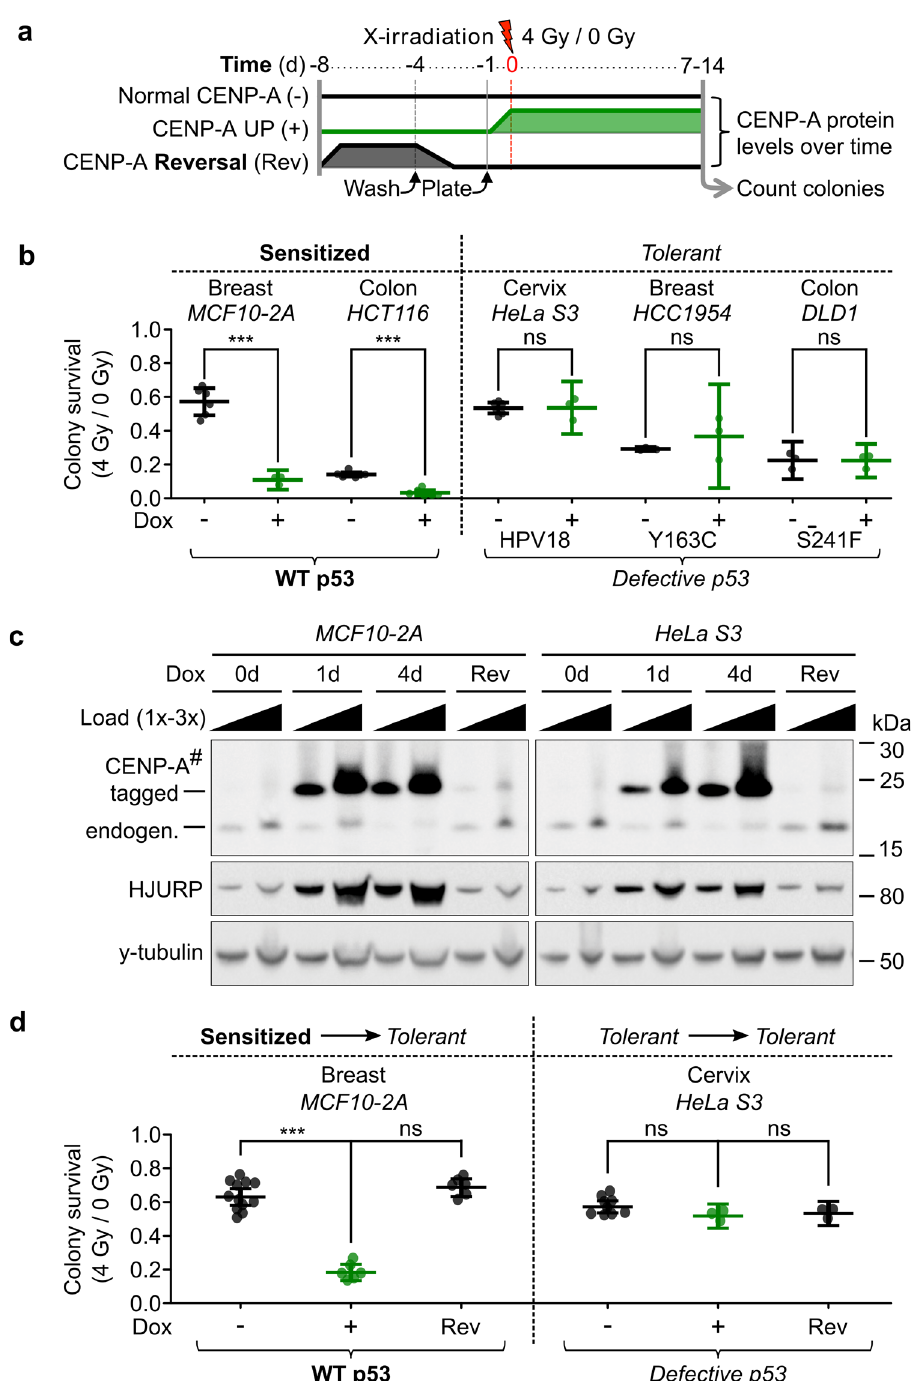
Fig. 2 Induced CENP-A overexpression causes reversible radiosensitivity in p53 wild-type cells. a Scheme of colony formation assays (CFAs) with relative CENP-A protein levels over time for TetOn-CENPA cell lines. b CFA results corresponding to the scheme in ( a ) for fi ve different cell lines of varied tissue origins and p53 status, as indicated. Each dot represents a single biological replicate. Plots show mean and 95% con fi dence interval. Statistical signi fi cance tested by two-tailed Welch ’ s t test with Bonferroni cutoff at a p value of 0.01 ( α = 0.05). *** = p value < 0.0001. See also Supplementary Fig. 1C for survival ratios relative to untreated condition. c Western blot corresponding to scheme in ( a ): TCEs after 1 day (1d) or 4d with 10 ng/ml Dox, no Dox control (0d), or 4d Dox followed by 4d without Dox (Rev). Primary antibodies indicated on the left. 1x load = ~30,000 cells. # = high sensitivity ECL exposure. y-tubulin used as loading control. d CFA results corresponding to scheme in ( a ) for the indicated cell lines. Plots as in ( b ). Statistical signi fi cance tested by two-tailed Welch ’ s t test, compared to non-induced control, with Bonferroni cutoff at a p value of 0.0125 ( α = 0.05). *** = p value < 0.0001.